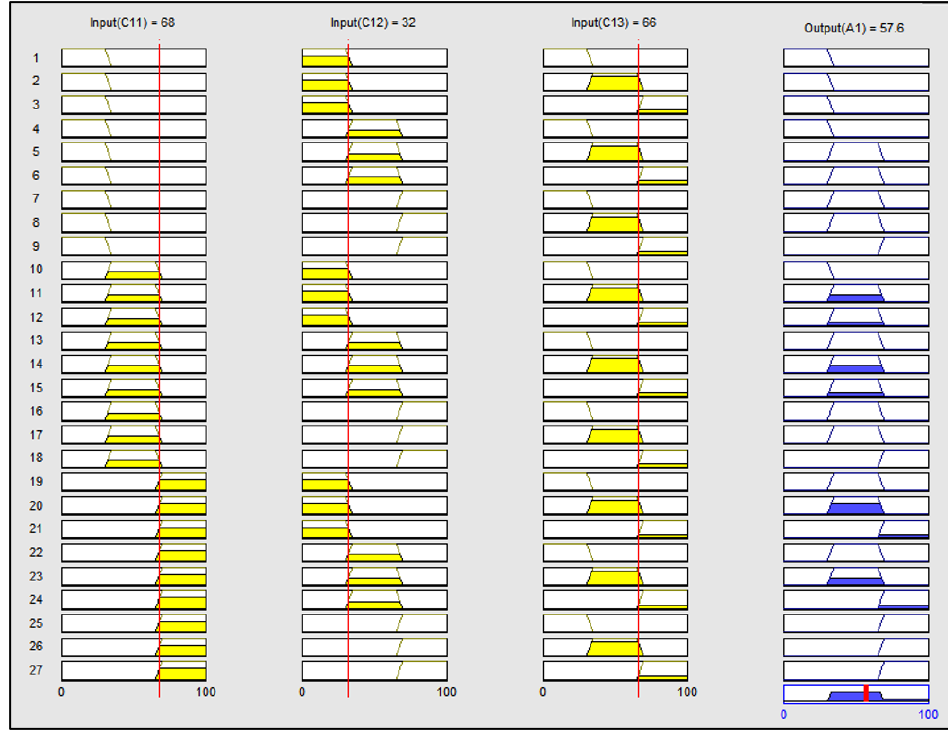
Figure 8. Rule viewer of the fuzzy inference system for strategy (A 1 ) aspect . Table 10. Basic Fuzzy Rule-Based System, a summary.